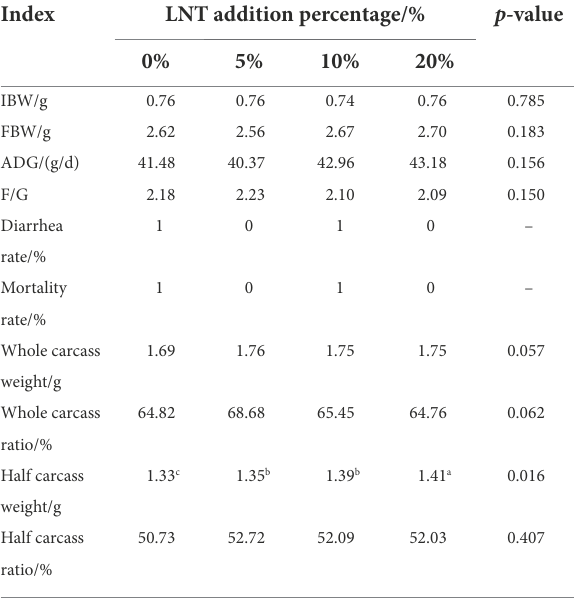
TABLE 1 Effects of LNT on growth performance and diarrhea incidence of meat